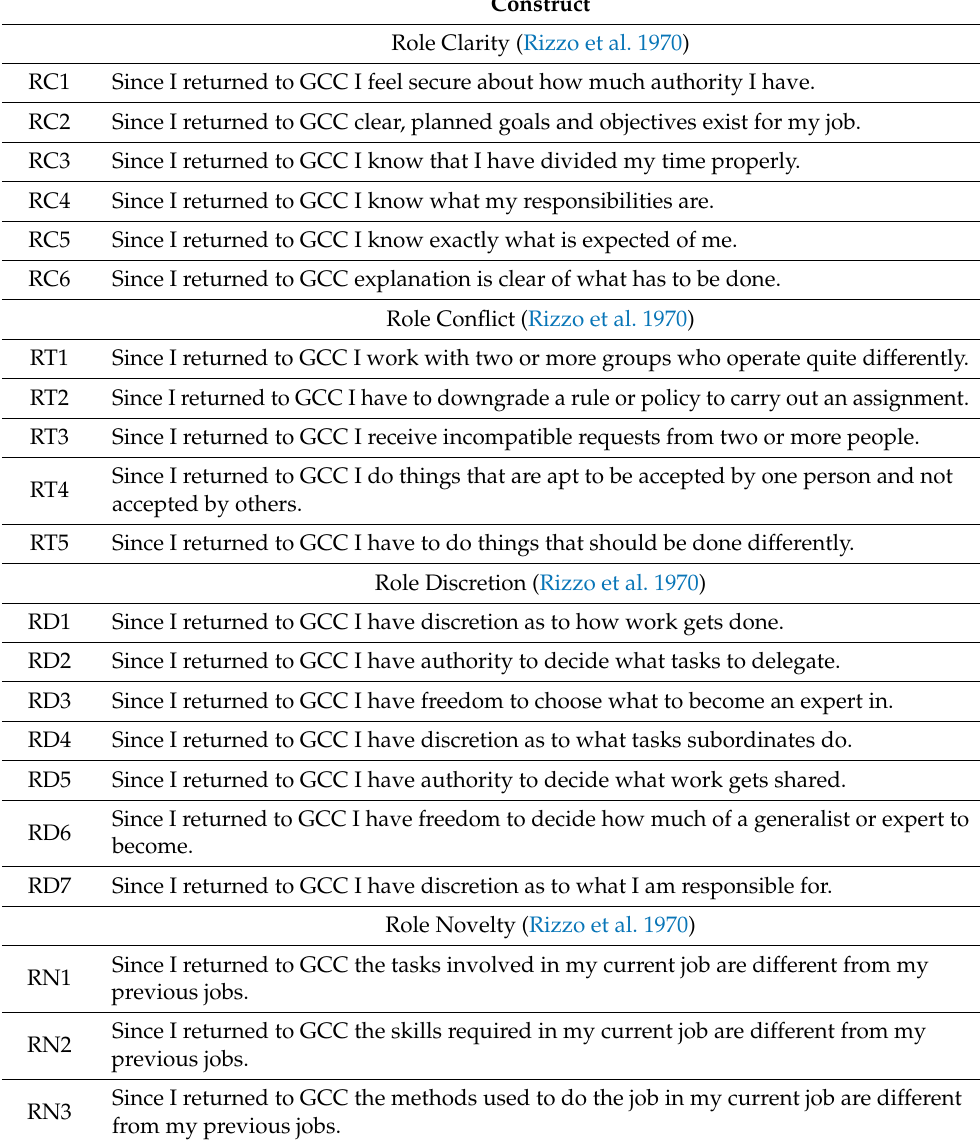
Table A1. Study’s questionnaire.